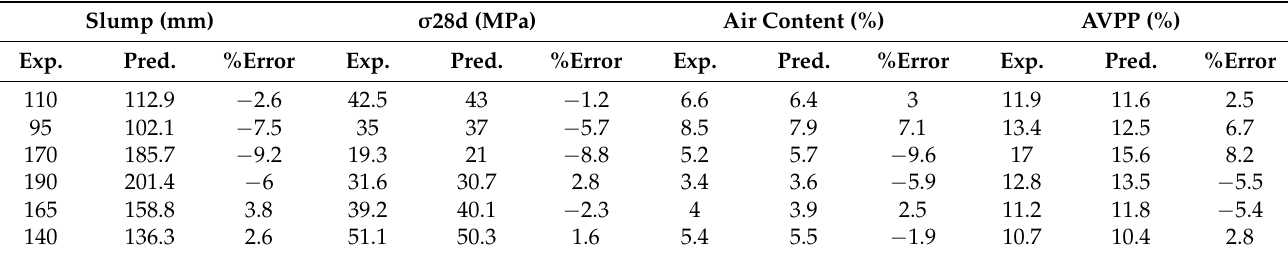
Table 8. Experimental and predicted results of the validation mixes.